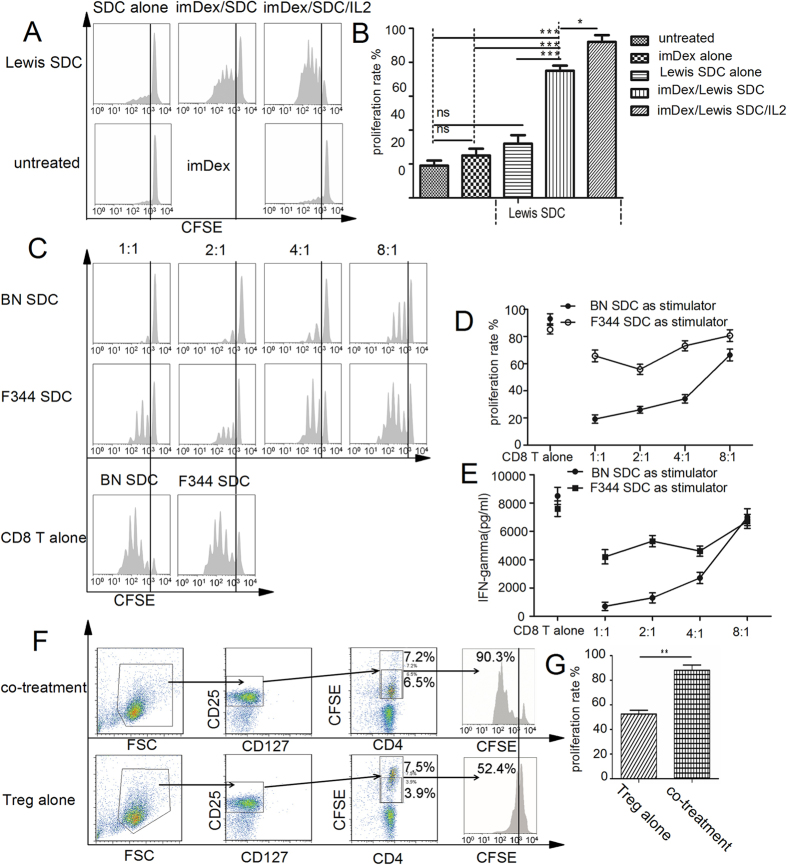
Donor-specific Tregs proliferation assays in vitro and in vivo.(A) In the Tregs expansion assay, as described in the Methods, 1 × 104 Lewis-derived BN-specific Tregs (CFSE-labelled) were cultured with 0.5 μg BN imDex alone, 2 × 104 Lewis SDCs, 0.5 μg BN imDex/Lewis SDCs or 0.5 μg BN imDex/Lewis SDCs/200 units/ml IL-2. Seven days later, CFSE intensity was measured by FCM, and representative results are shown. (B) The percentage of divided CFSE-labelled Tregs was analysed. (C) In the Tregs suppression assay, graded numbers of the imDex expanded Tregs were added to CFSE-labelled CD8a+ T cells as described in the Methods (n = 3 at each ratio). CFSE intensity was measured by FCM, and representative results are shown. (D) The percentage of divided CD8a+ T cells was assessed. (E) IFN-γ was measured and analysed in the above mixed-cell system. (F) In the in vivo assays, CD4+ CD25+T cells were isolated 10 d after transplantation from recipient splenocytes (BN-specific Tregs treatment or 20 μg donor imDex/BN-specific Tregs treatment group). Gated on CD4+ CD25+ CD127− CFSE+ cell subsets (representative FACS gates and results are shown in F), (G) the percentage of divided CFSE-labelled Tregs was analysed. *Indicates p < 0.05; **indicates p < 0.01; ***indicates p < 0.001; ns indicates no significant difference.